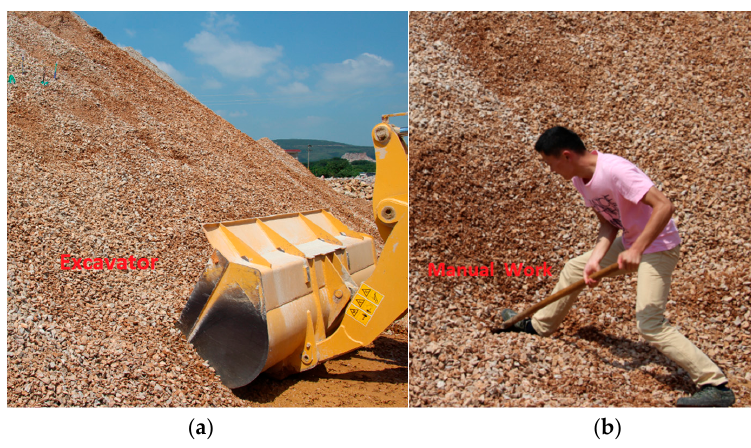
Figure 12. ( a ) Digging out the slope with an excavator; ( b ) Manually digging out the slope.